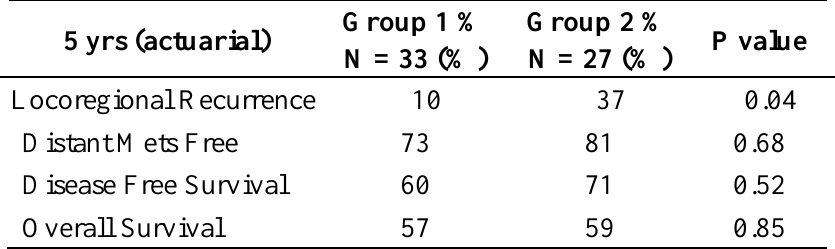
Table 5. Five years actuarial rates of Loco-regional Recurrence, Distant Mets Free, Disease Free Survival and Overall Survival.